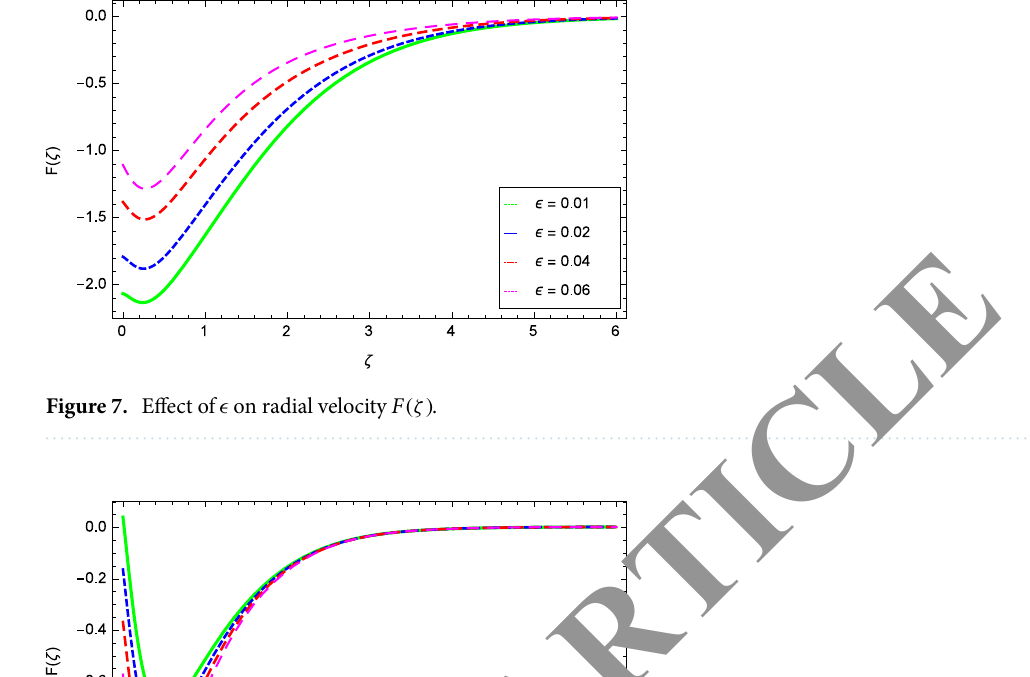
Figure 8. Effect of Fr on radial velocity F (ζ) .